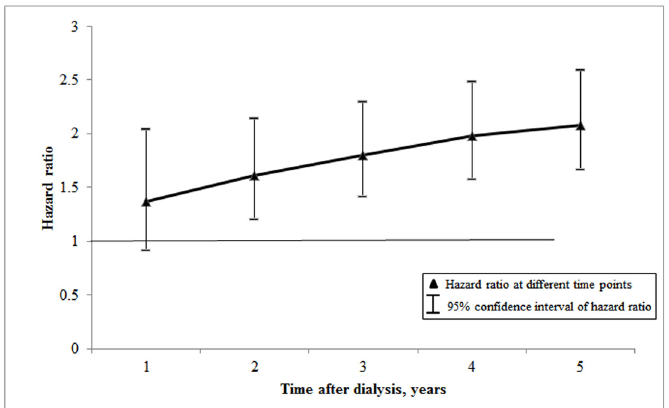
Fig 2. Hazard ratios for risk of death for patients initiating PD compared with those initiating HD and 95% confidence intervals using flexible RP model after adjusting for the effect of socio-demographic and clinical